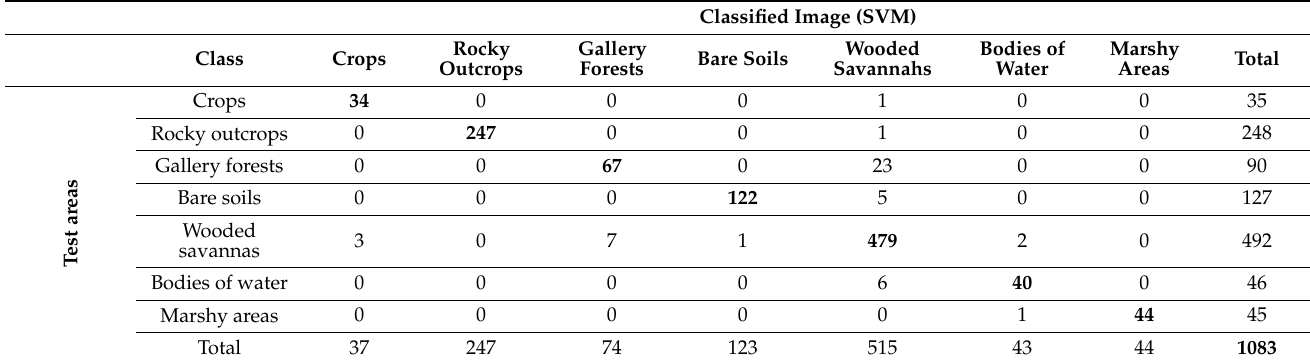
Table 5. Confusion matrix (Kappa = 0.934).